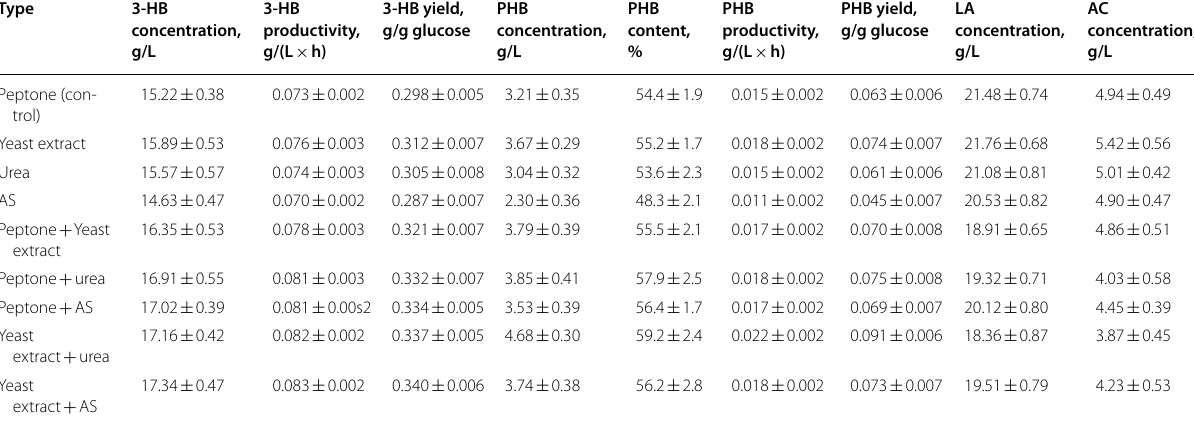
Table 6 The production of 3-HB, PHB, and by-products under the condition of different nitrogen sources